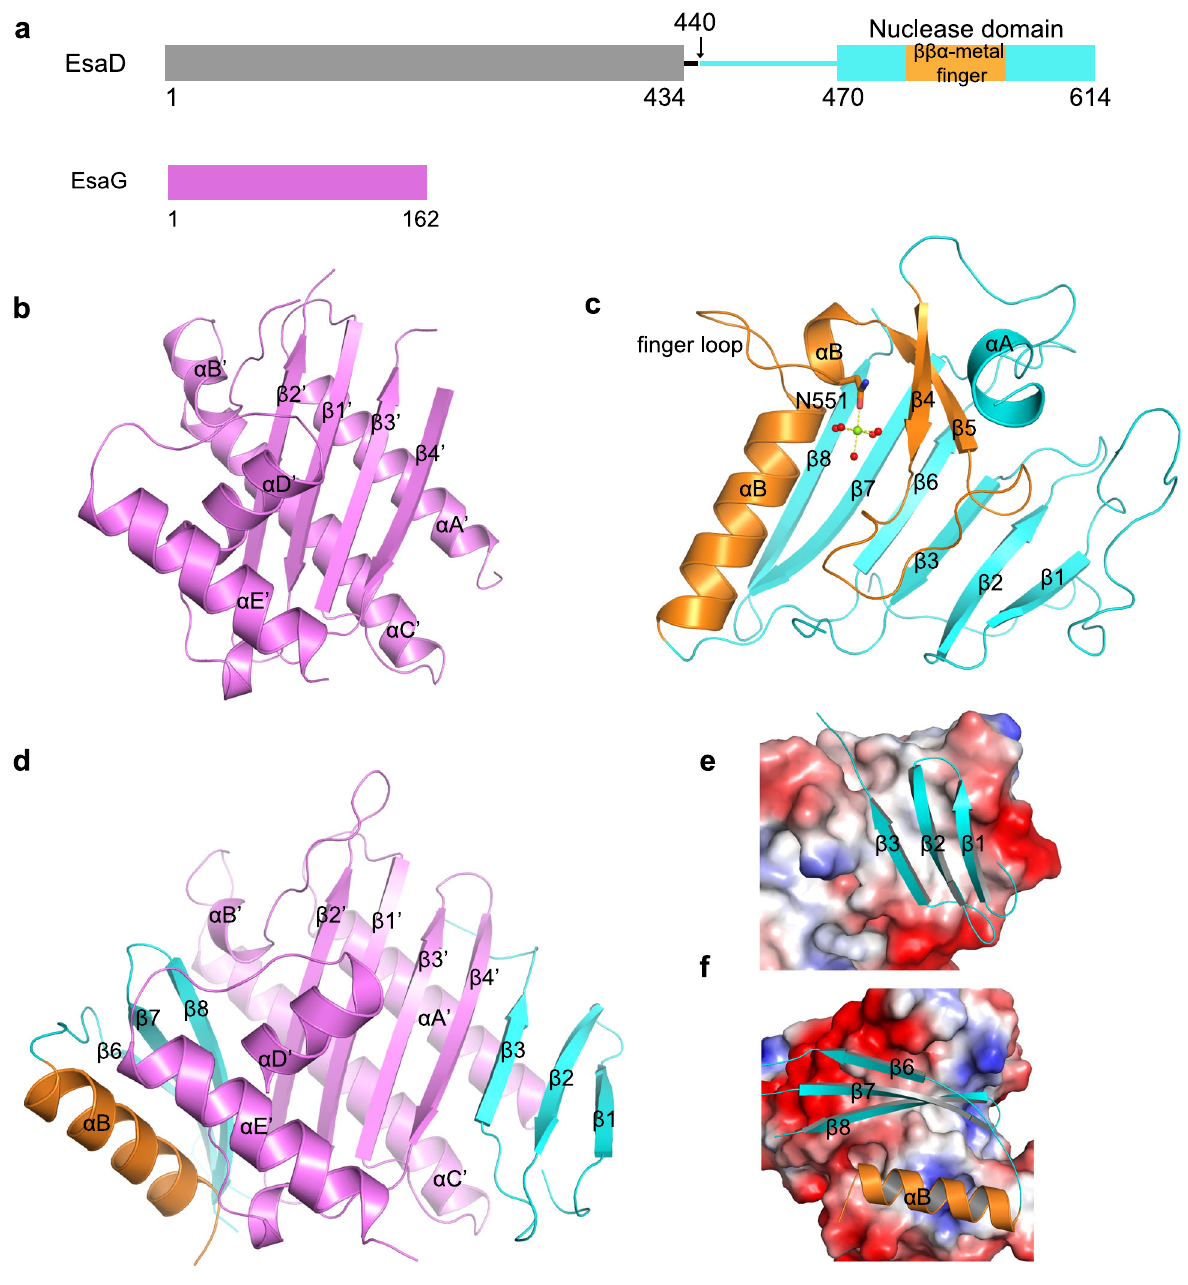
Fig. 1 | Structure of the nuclease domain of EsaD and EsaDc-EsaG complex. a Domain architecture of EsaD and EsaG, with individual domains colored differ- ently. Similar color schemes are used in the other fi gures unless otherwise indi- cated. b CrystalstructureofEsaG.The α -helicesand β -strandsarelabeledfromA ’ to E ’ andfrom1 ’ to4 ’ ,respectively. c CrystalstructureofthenucleasedomainofEsaD.